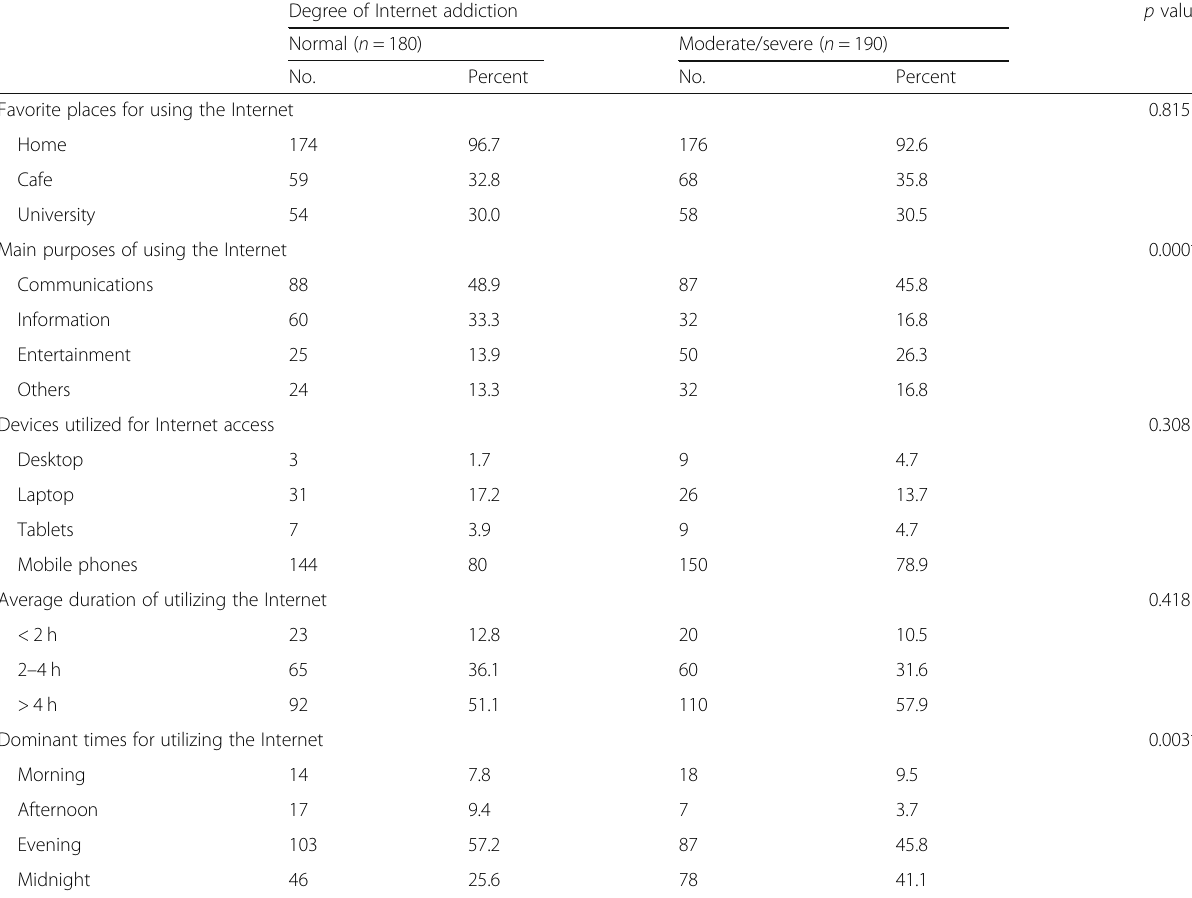
Table 4 Relationship between Internet addiction and the patterns of Internet use of female students at Jouf University, SA,